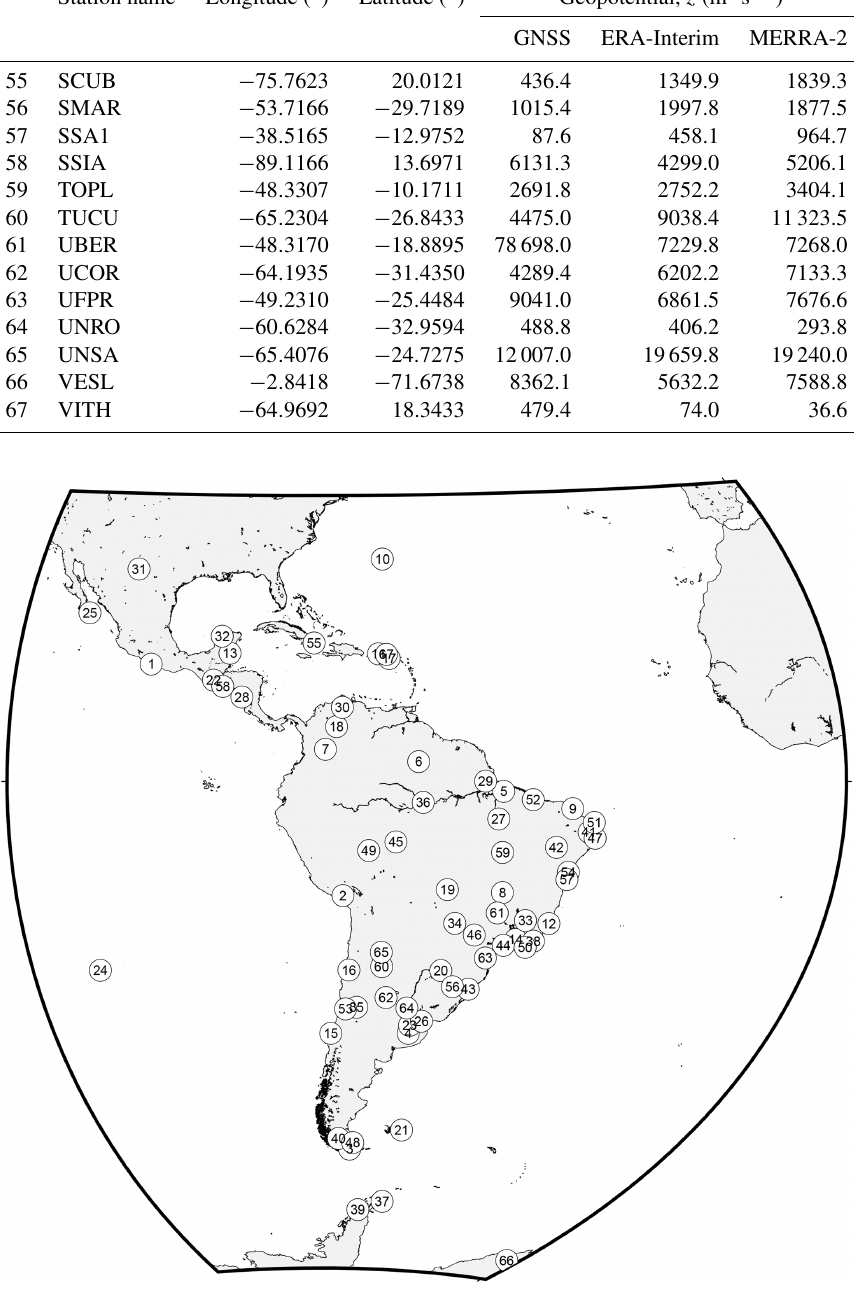
Figure 1. Location of the GNSS stations (see Tables 1 and